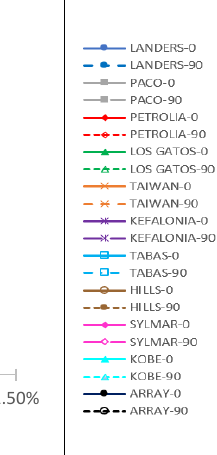
Figure 16. RIDR along X ( left ) and Y ( right ) horizontal directions of the five-story mixed building, considering the fixed- pinned connection of the steel structure to the r/c one.